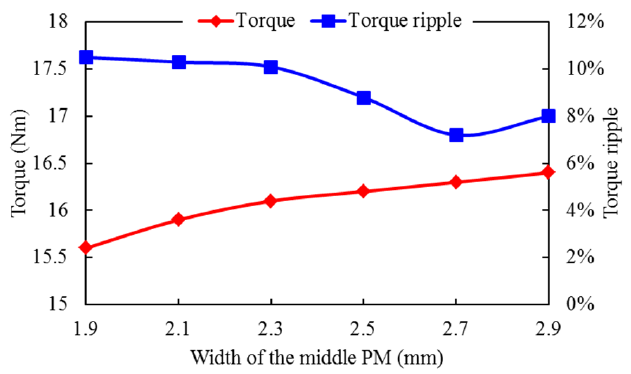
Figure 11. Variations of torque and torque ripple with the width of the middle PM.